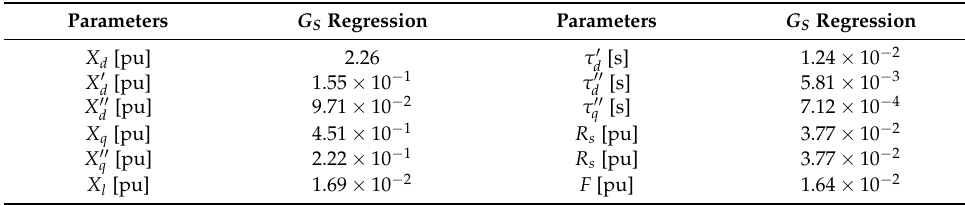
Table 4. Synchronous Machine Parameters.